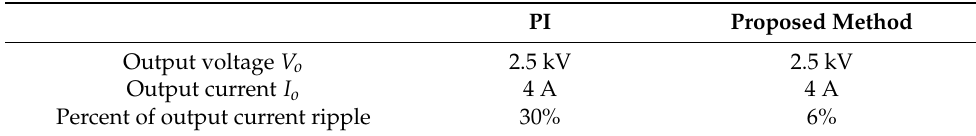
Table 5. Comparison between different control methods.